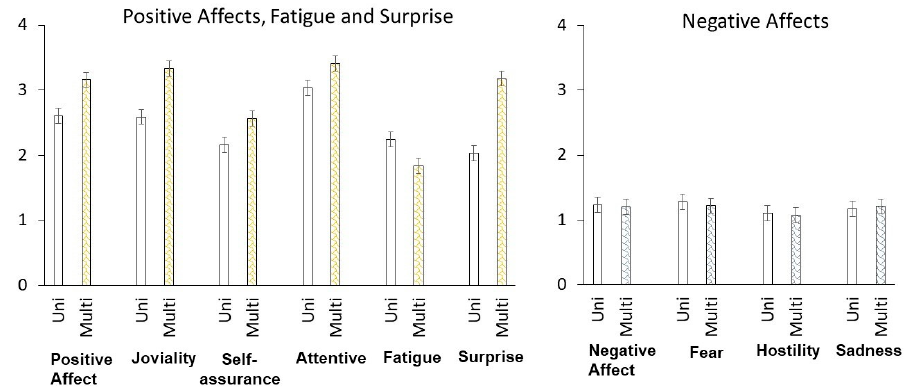
Figure 3. Mean PANAS ‐ X rating scores (1–5 Likert scale; 1 = very slightly/not at all; 5 = extremely) in the unimodal and multimodal conditions. Error bars represent two standard error units and the Y ‐ axis corresponds to participants’ self ‐ reported emotion ratings assessed in the PANAS ‐ X.